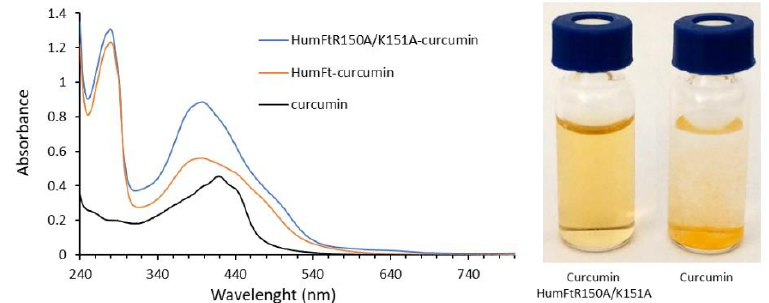
Figure 8. Loading of HumFtR150A/K151A and HumFt with curcumin. Left panel: UV-vis spectra of curcumin in 20 mM HEPES buffer pH 7.4 containing 50 mM MgCl 2 (black line) and of curcumin encapsulated in HumFtR150A/K151A (blue line) and in HumFt (orange line) after 48 hours dialysis. Right panel: Picture of samples containing HumFtR150A/K151A loaded with curcumin or curcumin alone in buffer.